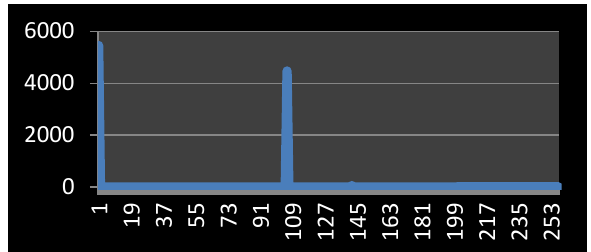
Figure 5. A Histogram consisting of 100x100 pixels from the sea part of the image.